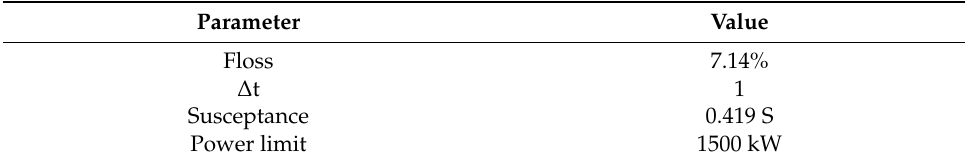
Table 2. Electrical system parameters of the test system. Taken from